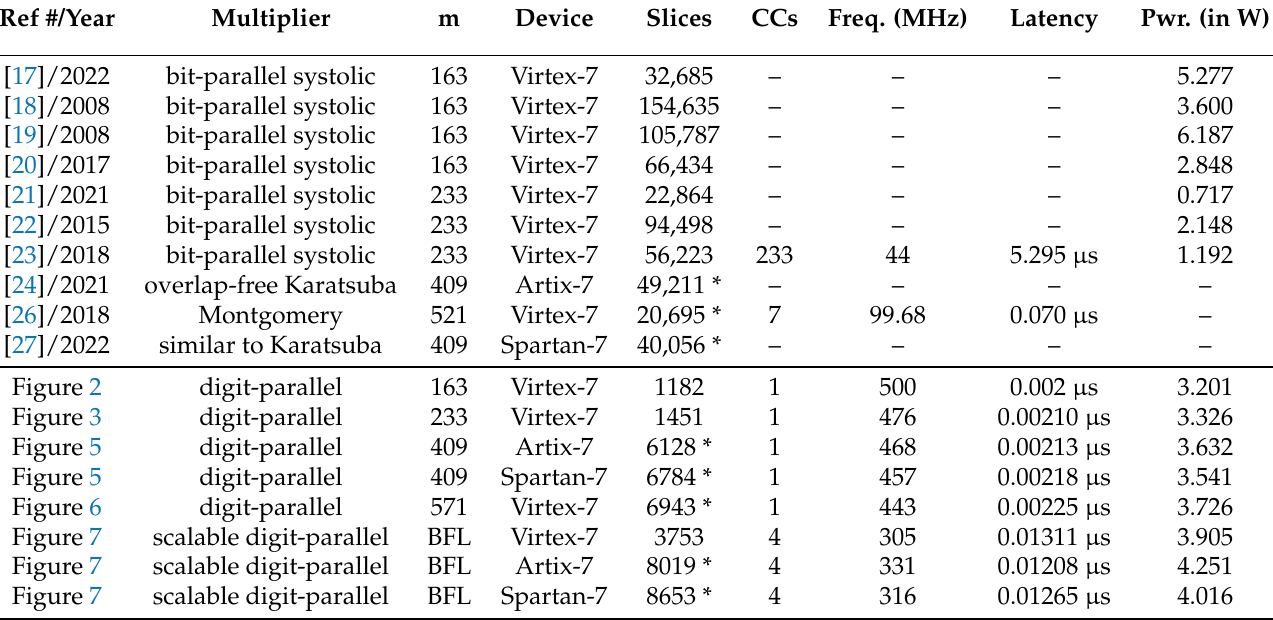
Table 2. Comparison of our proposed dedicated and scalable least-significant digit-parallel multiplier(s) over GF ( 2 m ) with state-of-the-art multipliers.